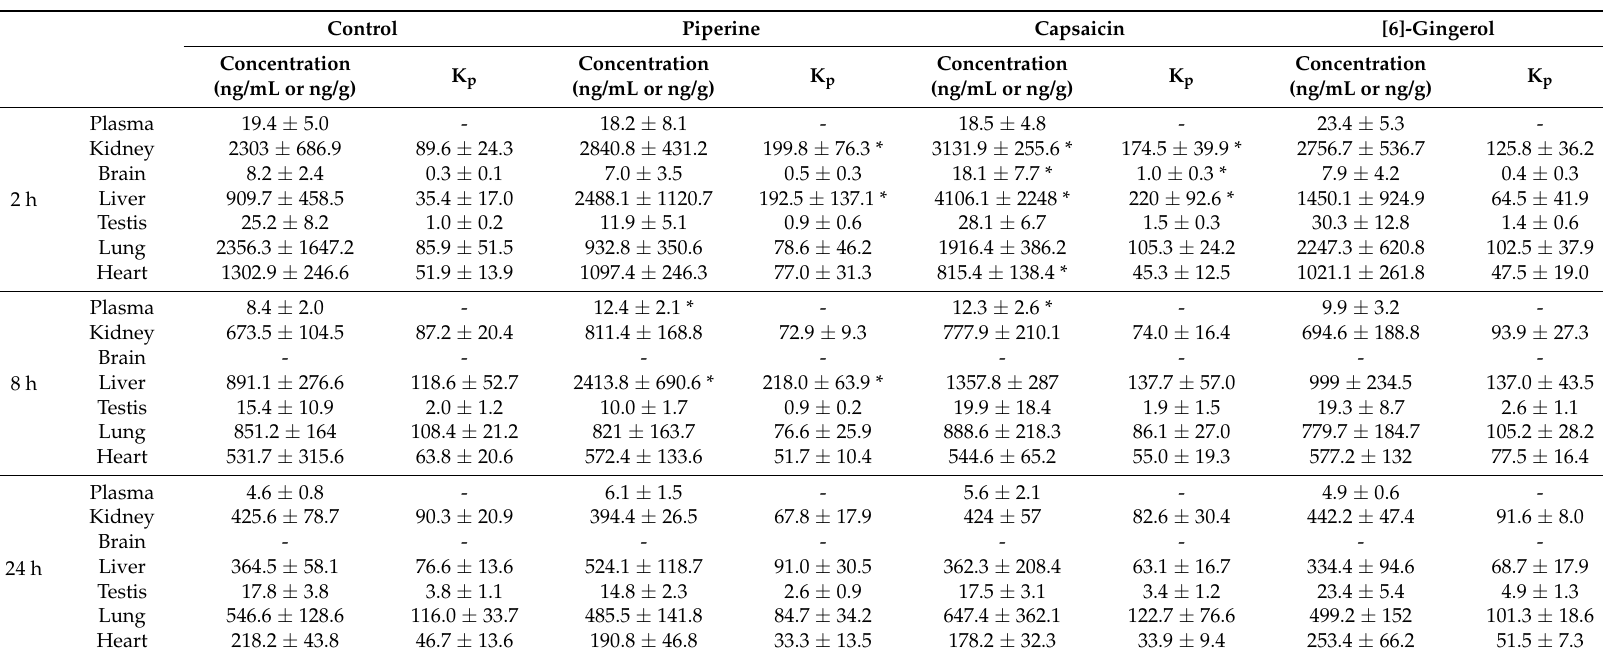
Table 4. Doxorubicin tissue concentrations and tissue to plasma partition coefficients (K p ) in mice pretreated with piperine, capsaicin and [6]-gingerol 2, 8 and 24 h after intravenous injection of doxorubicin at 1 mg/kg ( n = 6, mean ±